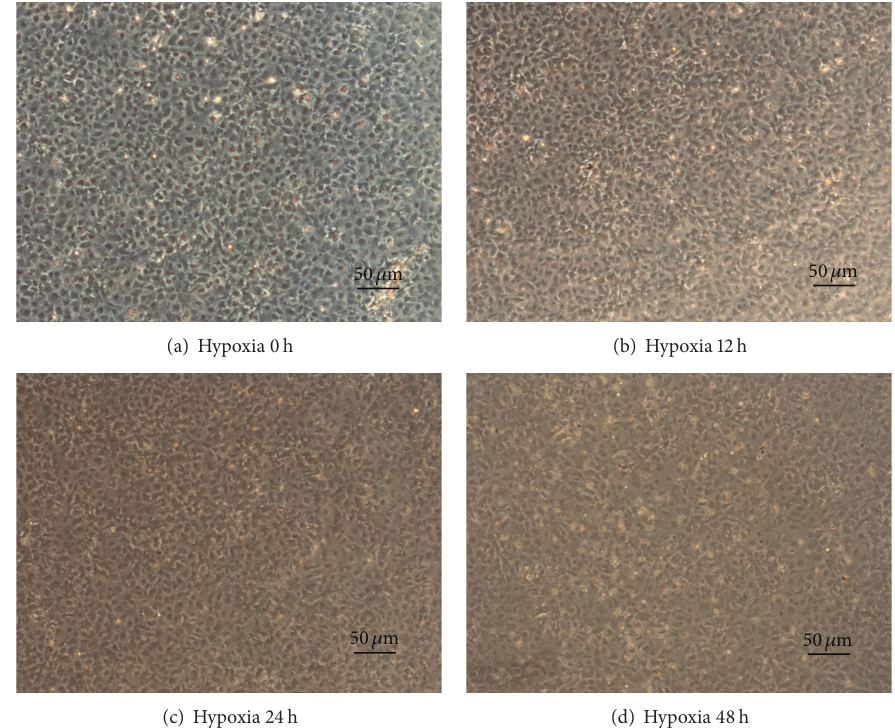
Figure 2: CFs morphological changes under hypoxia. (a) shows the control when CFs were to be incubated under hypoxia. (b) (12h), (c) (24 h), and (d) (48 h) demonstrate that CFs were incubated by different length under hypoxia. CFs became less stereoscopic in the hypoxic